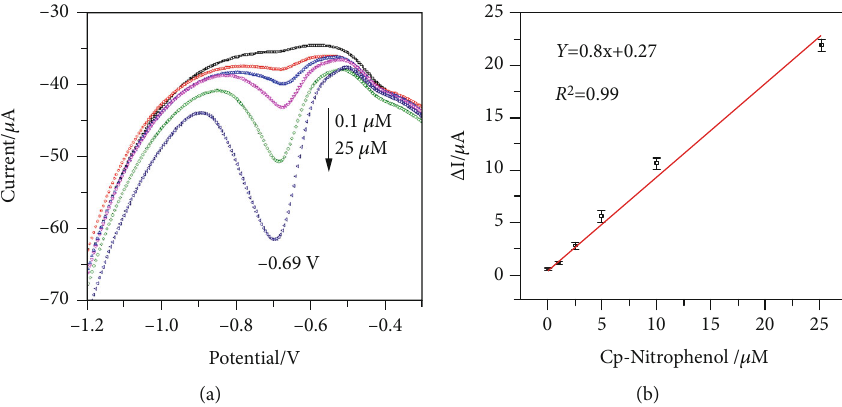
Figure 7: DPV in 0.1M PBS (pH7.4) containing di ff erent concentrations of 4-NP: (a) biogenic AgNPs-SPE for 4-NP at di ff erent concentrations and (b) linear relationship between peak currents and 4-NP concentrations.